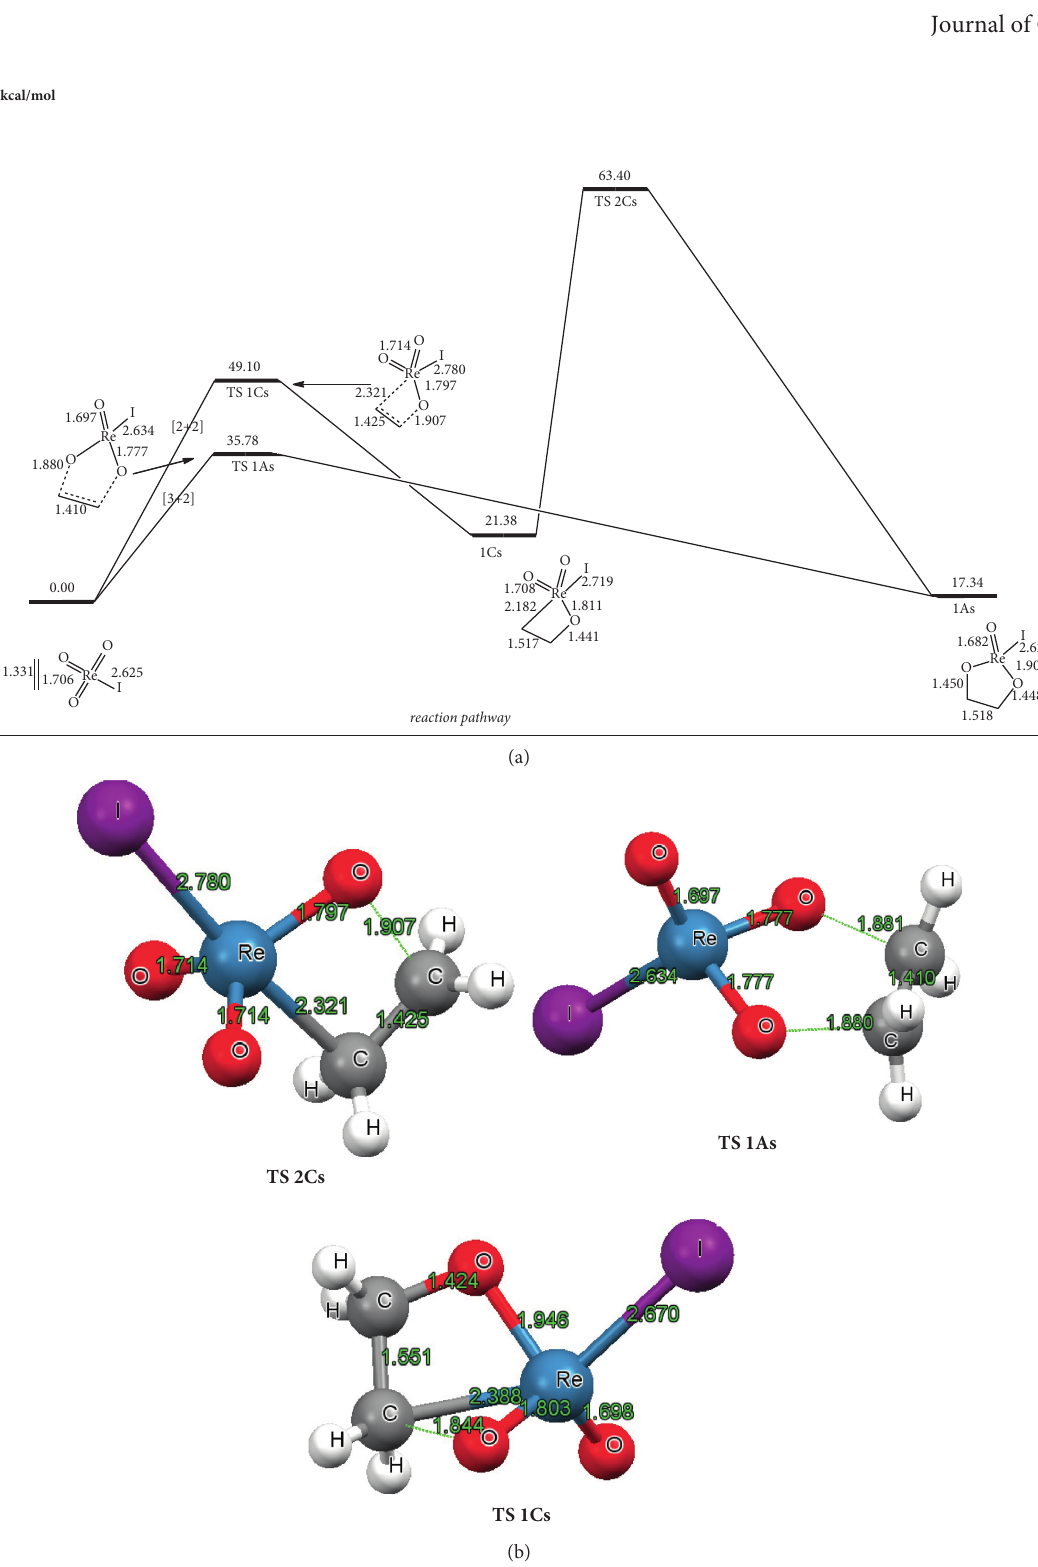
Figure 3: (a) Gibbs free-energy profile diagram for the reaction between ReO Optimized transition states involved in the reaction between ReO 3 I and ethylene at the B3LYP/LACVP ∗ level of